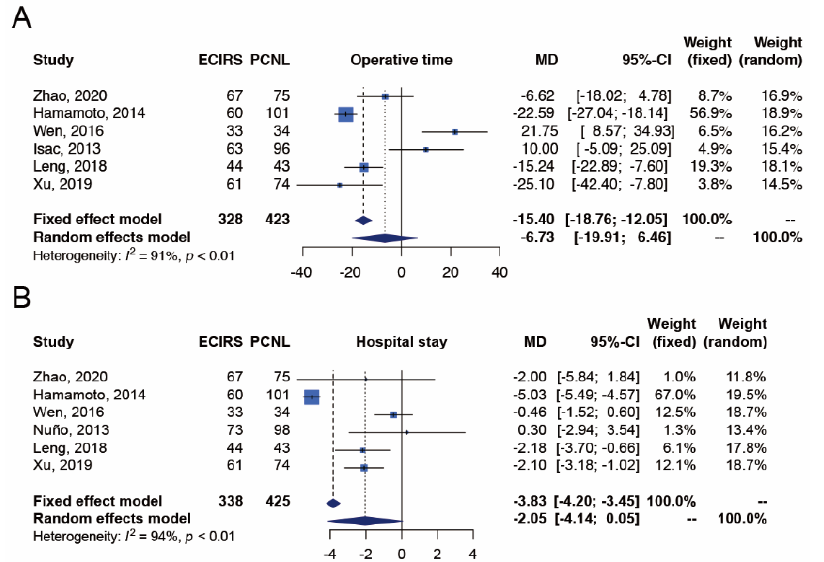
Figure 5. Meta-analysis of efficiency outcomes, including ( A ) operative time [17–19,21–23] and ( B ) hospital stay [17-20][22,23] between ECIRS and PCNL groups.